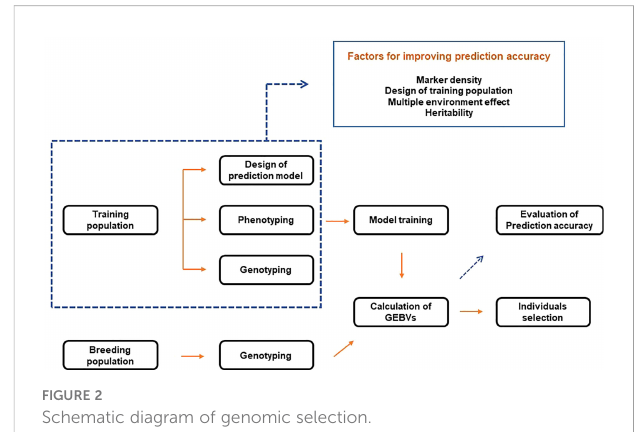
FIGURE 2 Schematic diagram of genomic